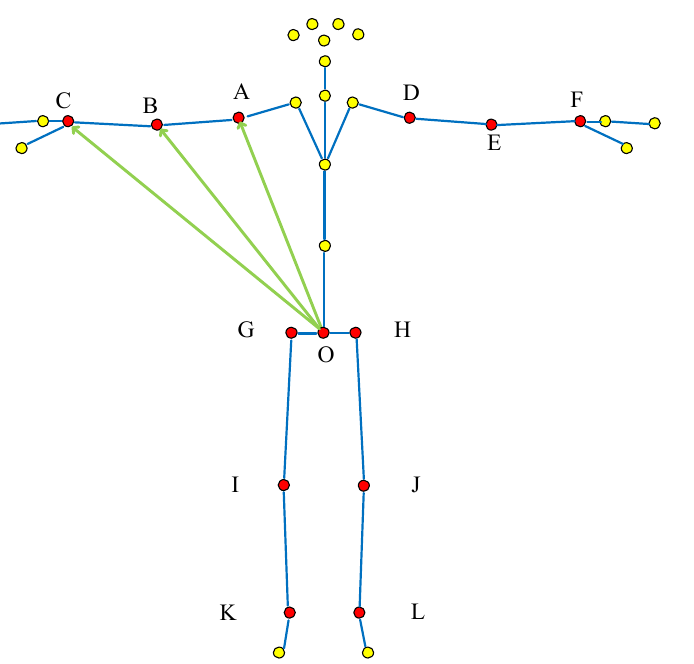
Figure 6. Local “pelvis divergence method” vector selection (The red dots are the selected bone joint, and yellow dots are bone joint points that do not need to be selected; Green lines are selected joints, blue lines are not selected joints; The letters correspond to Table 1 and Figure 1).